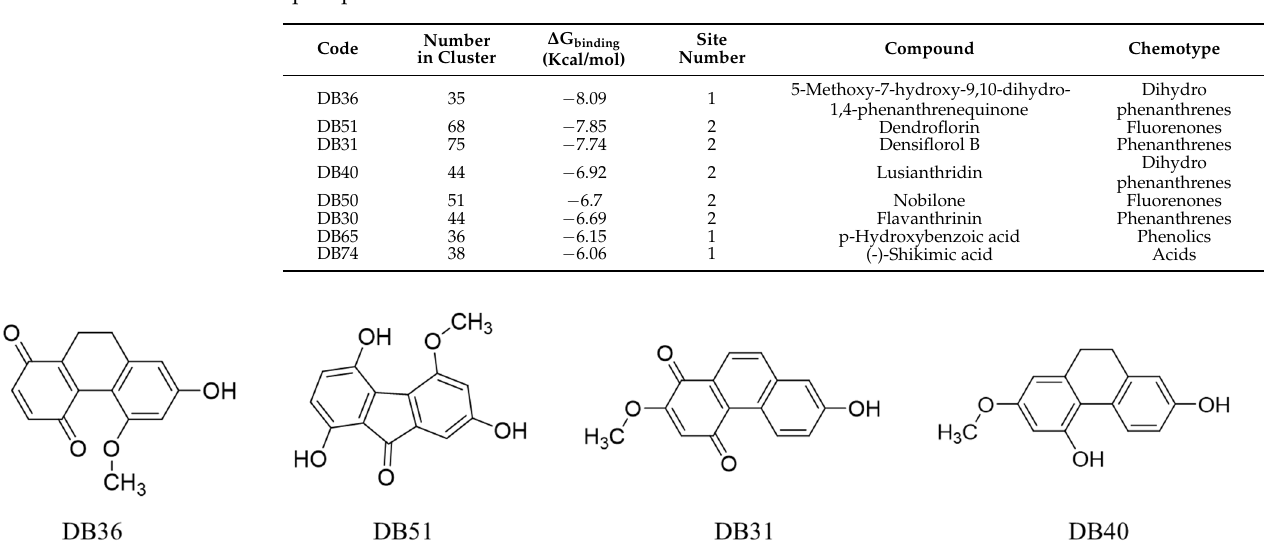
Table 1. Docking result of the top-ranking compounds from Dendrobium sp. against the SARS-CoV-2 spike protein.